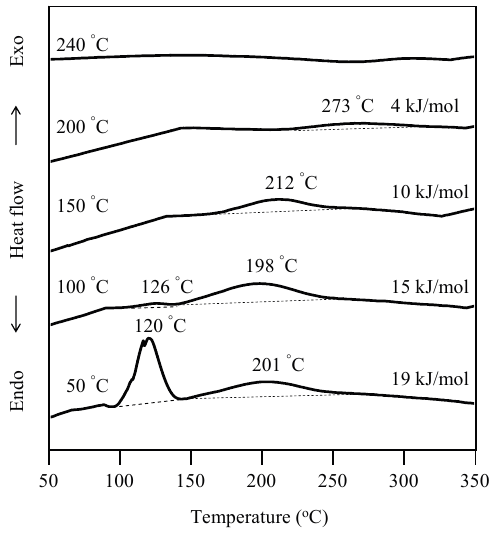
Figure 9. DSC thermograms of oligo(P-4va) after each cure stage.